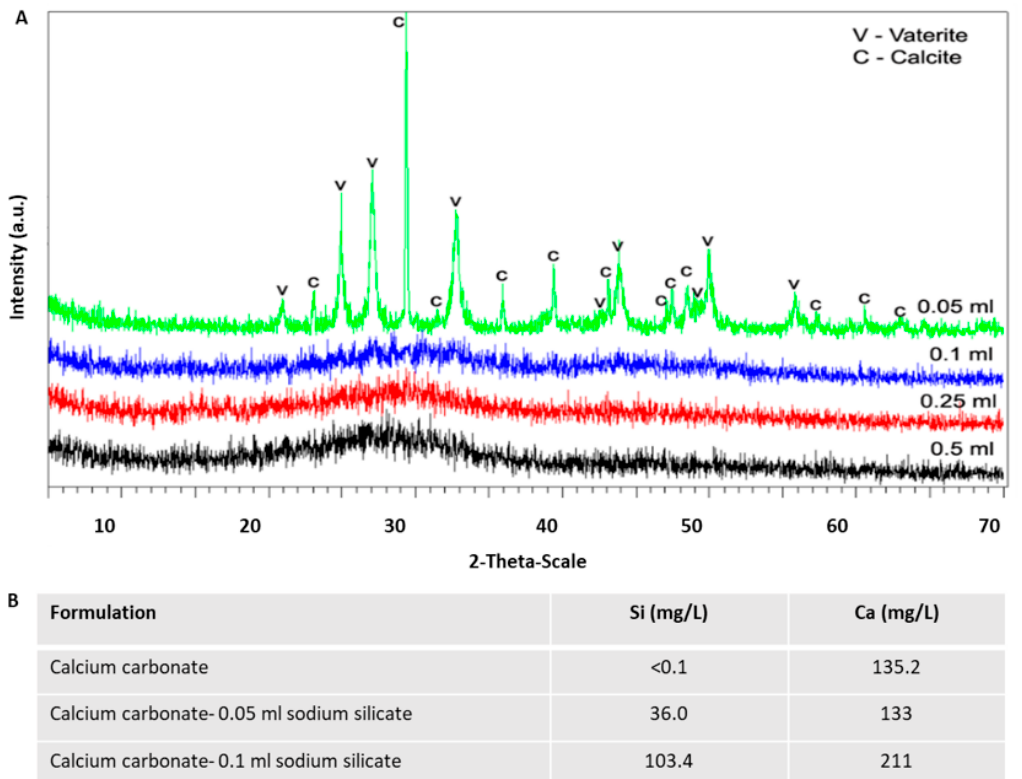
Figure 5. Calcium carbonate synthesized with elevated concentrations of sodium silicate. Decreasing sodium silicate con- centration from 0.5 mL (1% v/v ) to 0.05 mL resulted in a shift from amorphous material (high silicate) to calcite (no silicate) as assessed by XRD graphs ( A ) and numeral data ( B ).